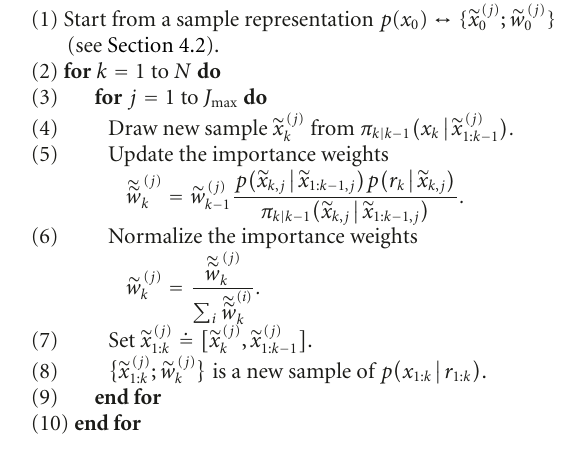
Algorithm 1: Sequential importance